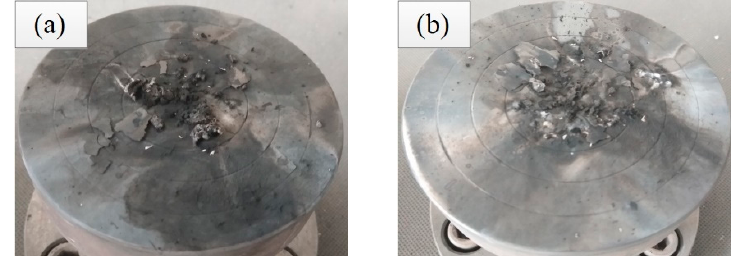
Figure 4. Reaction residues of completely reacted specimens under quasi-static compression ( a ) specimen 1# and ( b ) specimen 2#.